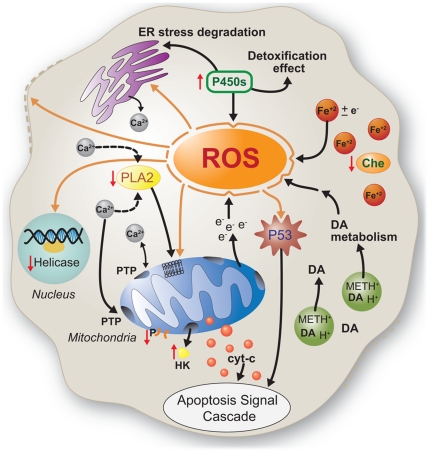
METH exposure may promote oxidative stress through multiple
mechanisms.First, cytochrome P450s are up-regulated (upward-pointing red arrow) to
potentially detoxify METH but in some cases also produce reactive oxygen
species (ROS) byproducts. Second, METH, a weak base, is known to
alkalinize dopamine (DA)-containing vesicles, promoting DA release into
the cytosol. Cytosolic DA is rapidly degraded, resulting in ROS
byproducts. Third, iron chelators are down-regulated (downward-pointed
red arrow), potentially increasing the concentration of free iron, a
known source of ROS. Fourth, degradation of the mitochondria,
potentially resulting from (i) the ability of high cytosolic
Ca2+ to promote the formation of permeability
transition pores (PTP), (ii) increased membrane hydrolysis by
Ca2+-dependent phospholipase A2 (PLA2) in
the presence of increased Ca2+, (iii) the direct effects
of ROS on mitochondrial integrity, and (iv) the potential effects of
altered HK/porin ratio - HK detachment from mitochondria on PTP
formation. This may cause the mitochondria to uncouple and result in ROS
production. The cellular targets of oxidative stress, indicated by
orange arrows, include membrane phospholipids; p53, a gene that
regulates apoptosis; and DNA.